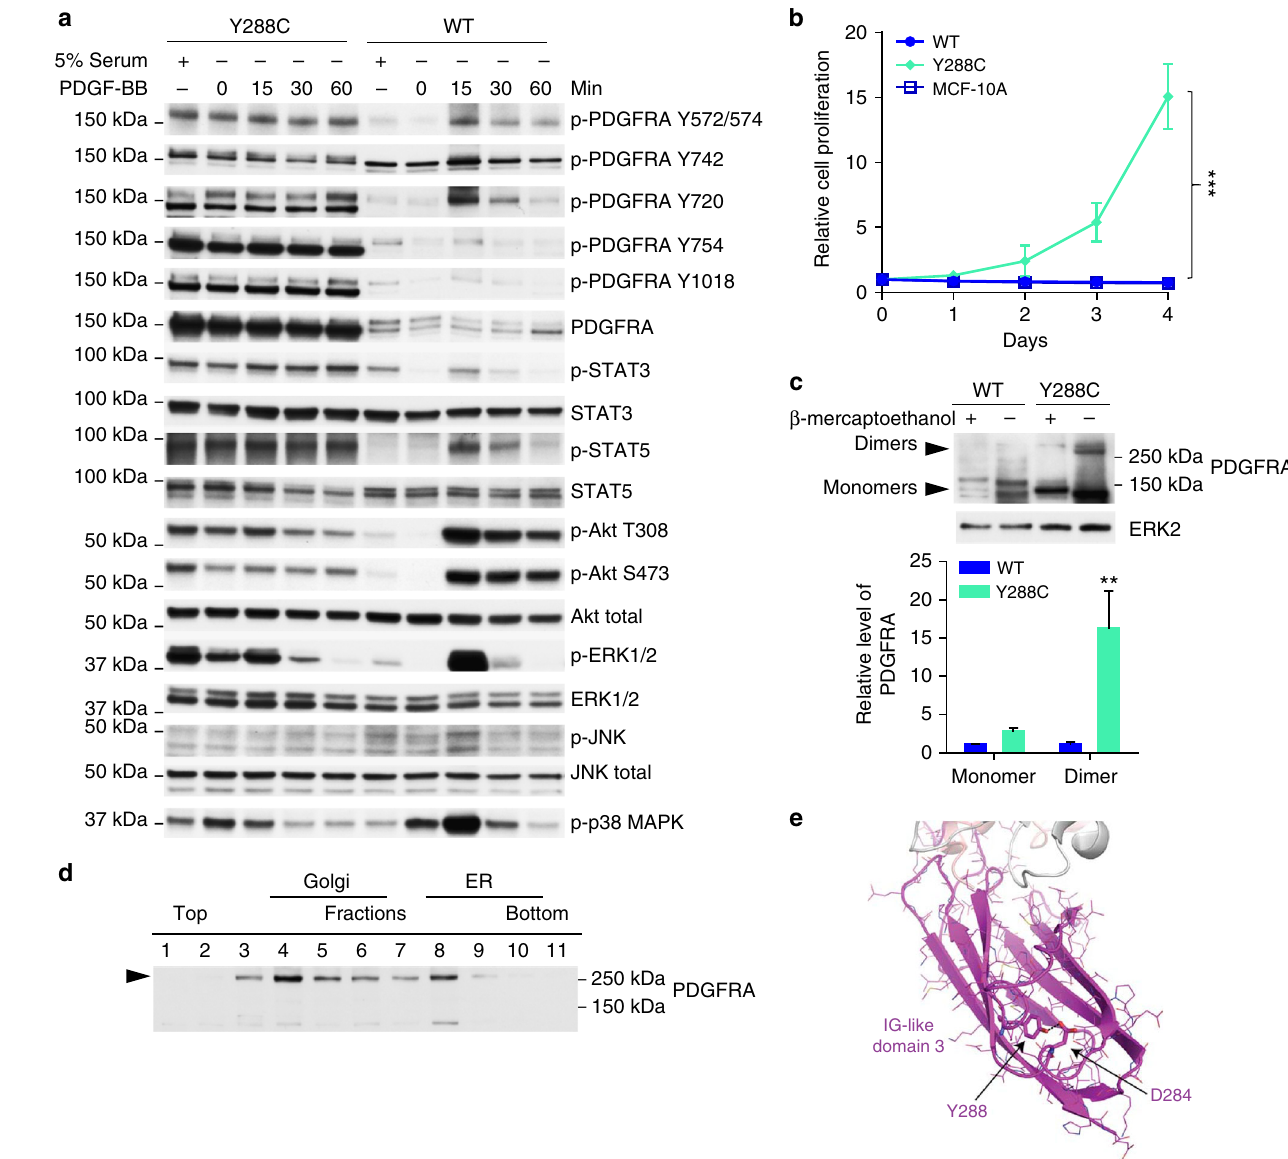
Fig. 3 Y288C protein is constitutively active at ER and Golgi. a MCF10A cells stably expressing PDGFRA WT (right) or Y288C (left) were serum-starved for 16 h and stimulated with PDGF-BB (50 ng ml -1 ) for 15 – 60 min. Whole cell lysates were resolved by SDS-PAGE and blotted with indicated antibodies to analyze for the activation of PDGFRA and different downstream signaling pathways. Corresponding total proteins were used as loading controls. b Relative cell proliferation of MCF10A parental, PDGFRA WT or Y288C expressing cells in the absence of serum of three independent replicates was assessed for 4 days (exponential growth equation). c Protein lysate of MCF10A expressing PDGFRA WT or Y288C were resolved by SDS-PAGE in the presence or absence of β -mercaptoethanol. Monomeric and dimerized PDGFRA were detected by anti-PDGFRA antibody, and ERK2 was used as loading control. The band intensities of monomers and dimers from three independent experiments were measured by densitometry and normalized to ERK2. The levels of PDGFRA monomers and dimers were presented as mean ± SD relative to WT. The statistical signi fi cance of dimer vs the corresponding monomer was assessed by Student ’ s t -test. d Y288C receptor dimerization in ER and Golgi was analyzed by western blot of the OptiPrep gradient ultracentrifugation resolved membrane fractions in the absence of reducing agent. e Homology model of the Ig-like domain 3 of PDGFRA predicted a hydrogen bond formed between the carboxylate group of D284 and the hydroxyl group of Y288. ** p < 0.01; *** p <